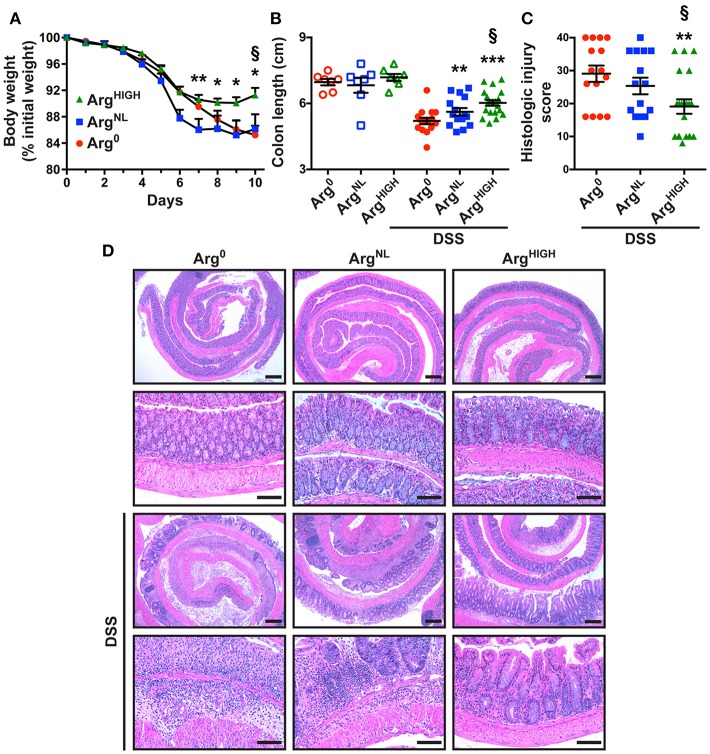
Effect of Arg on DSS colitis. C57BL/6 mice were treated with 2.5% DSS for 5 days and then kept for 5 more days under conditions of Arg0, ArgNL, or ArgHIGH diets. (A) Body weights were monitored daily and are presented as percentage of initial body weight. (B) Colons were harvested and measured. (C,D) Colons were Swiss-rolled and stained with H&E (D) and scored for histologic injury (C); the histologic injury score of mice without DSS was 0. Scale bar, 50 μm. In all panels, *P < 0.05, **P < 0.01, and ***P < 0.001 compared to DSS-treated mice on the Arg0 diet; §P < 0.05 vs. DSS-treated mice on the ArgNL diet, by ANOVA with the Tukey test.